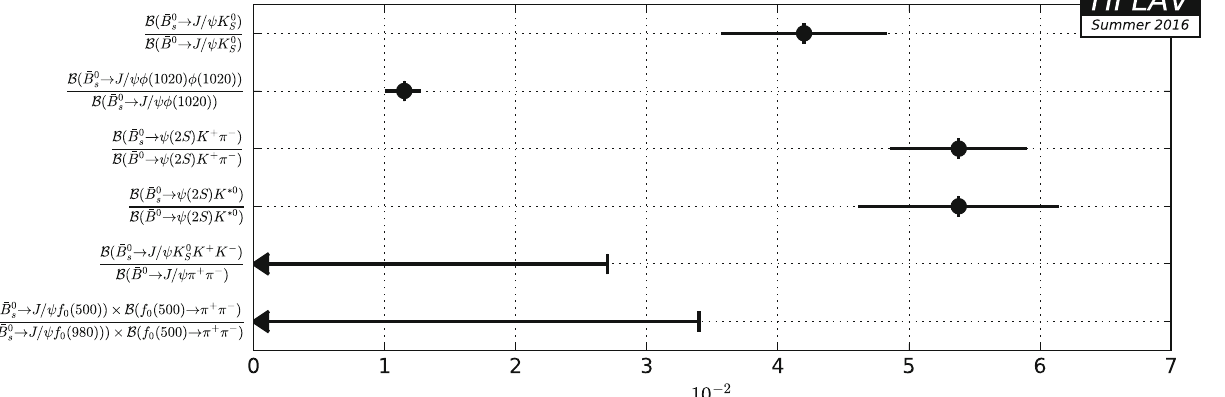
Fig. 165 Summary of the averages from Table